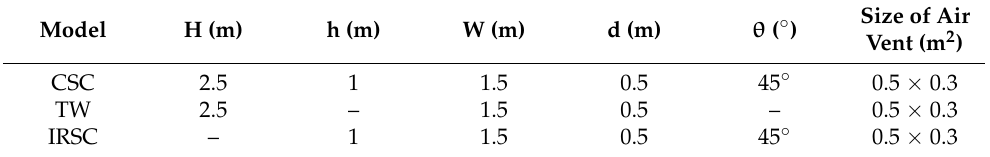
Figure 2. Models of a solar chimney with different structures: ( a ) CSC; ( b ) TW; and ( c ) IRSC. Table 1. Geometrical parameters of the different models of a solar